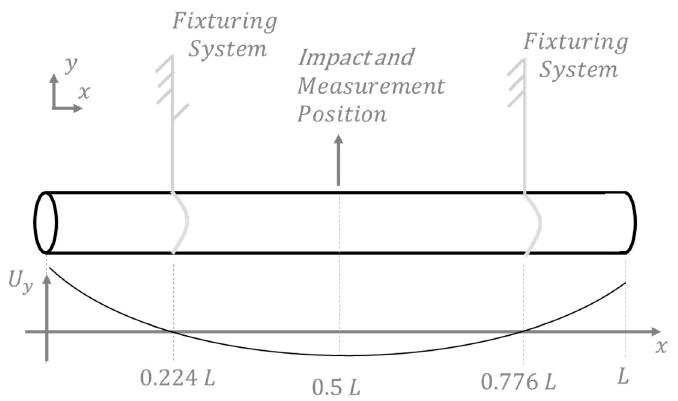
Figure 6. Experimental apparatus for elasticity modulus measurement.